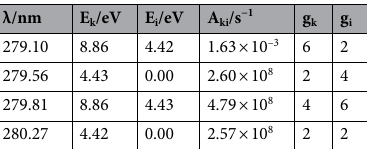
Table 6. List of Mg II lines for plasma temperature calculation and corresponding spectroscopic